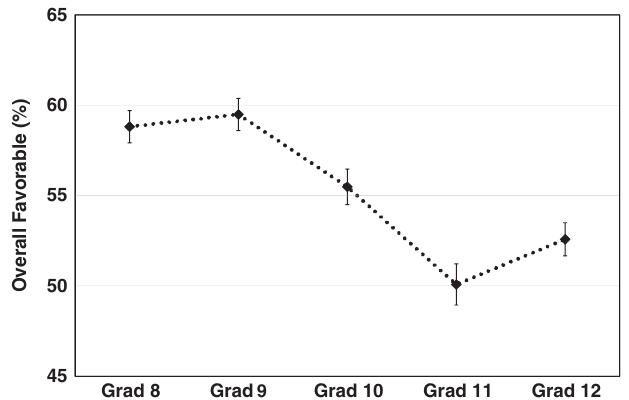
FIG. 2 (color online). Student overall favorable percentages on CLASS across grade